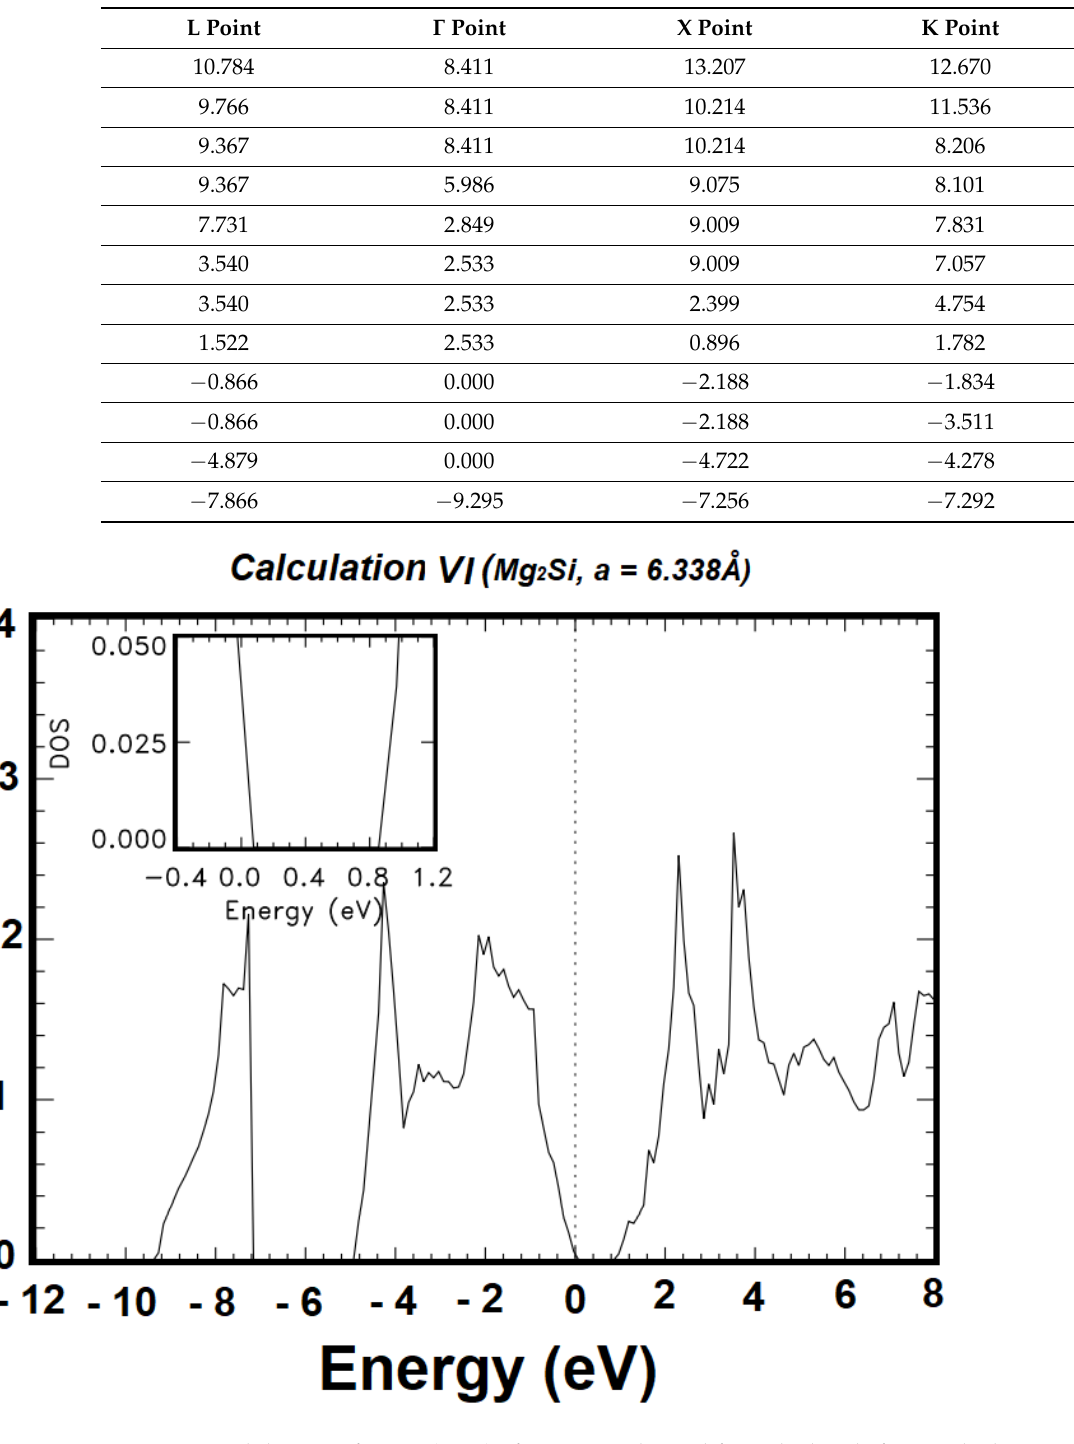
Figure 4. Total density of states (DOS) of Mg 2 Si, as derived from the bands from Calculation VI, shown in Figure 3. The vertical dashed line indicates the position of the Fermi level. The insert panel is the magnified DOS near the band gap, with 20-fold magnification.